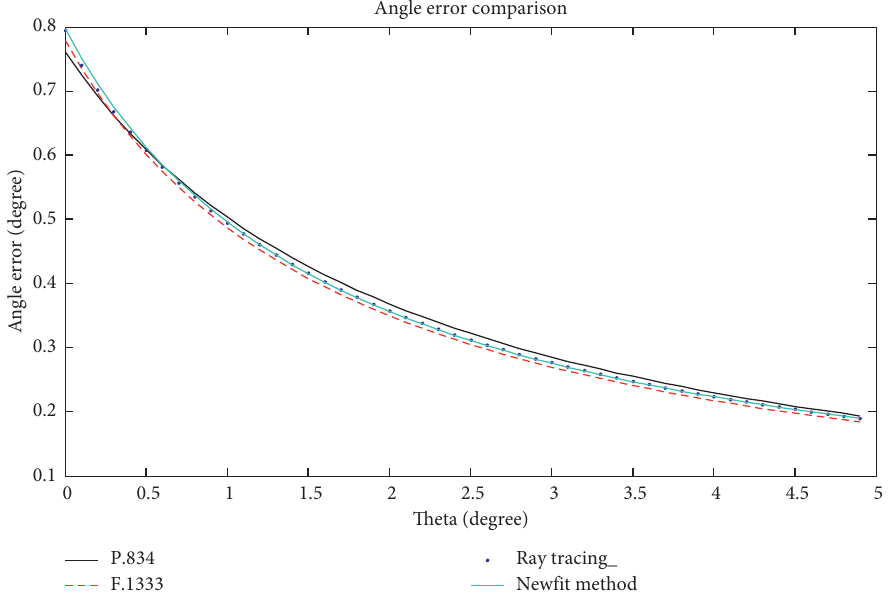
Figure 5: Comparison of the different methods at sea level and below 5 ° .